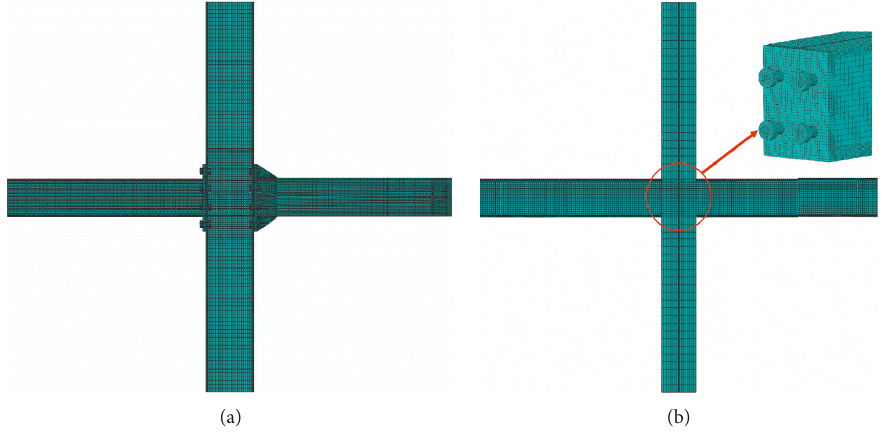
Figure 5: FE model and mesh division. (a) Major-axis connection. (b) Minor-axis connection.